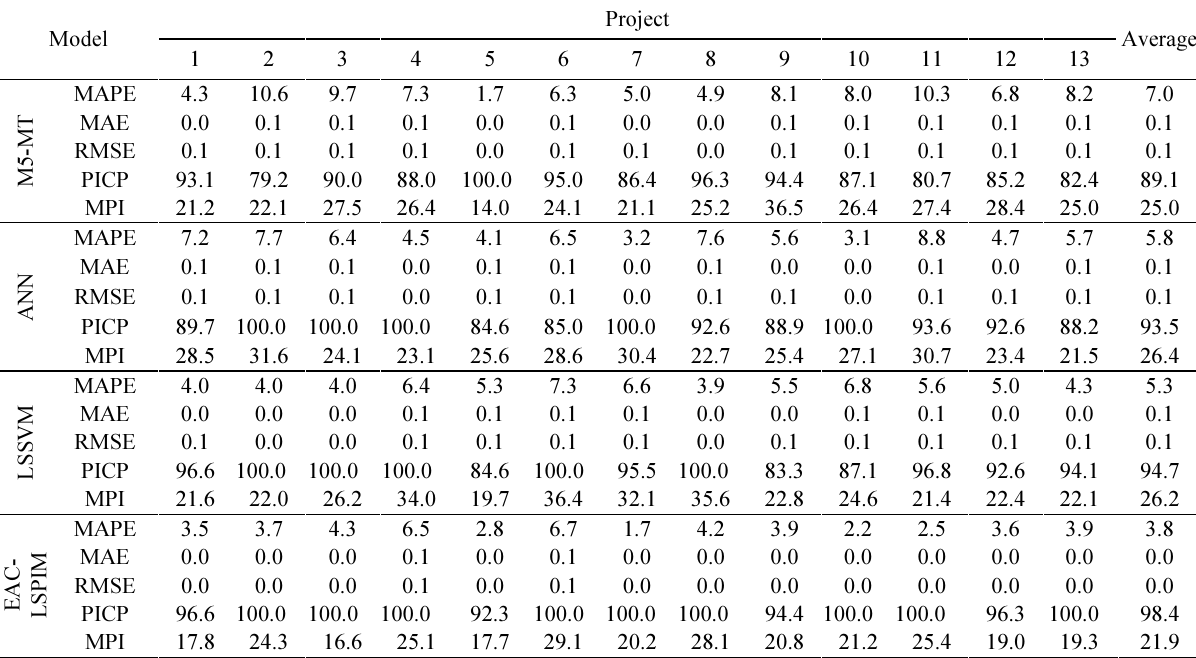
Table 8. Prediction result comparison for 13 projects Model